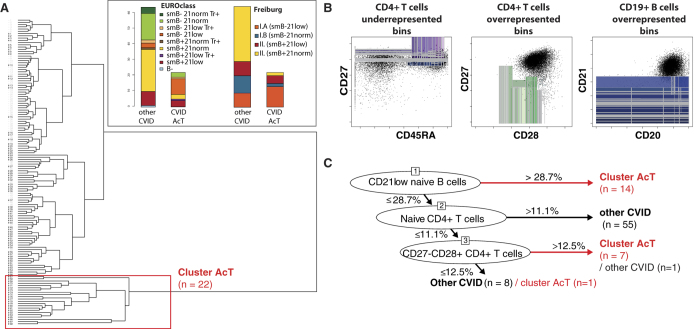
Unsupervised clustering of the phenotypic profiles of lymphocytes in CVID patients.Hierarchical tree of CVID patients (black) and healthy donors (grey) clustered with respect to B- and CD4+ T-cell phenotypes using a probability binning approach. A distinct cluster of CVID AcT patients (red frame) was formed (A). Although the comparison showed a non-random pattern, the composition of the clusters did not follow the EUROclass nor Freiburg classifications (inset A). To determine the phenotypic hallmarks of the clusters, differentially fed bins in CVID-Act were determined (highlighted as colored rectangles) and projected over a typical phenotype of normal healthy controls (black dots) (B). A classification tree was fitted using conventionally gated B-cell and CD4+ T-cell subsets (see gating in Fig. 2) in order to find a simplified definition of CVID- AcT patients (C).